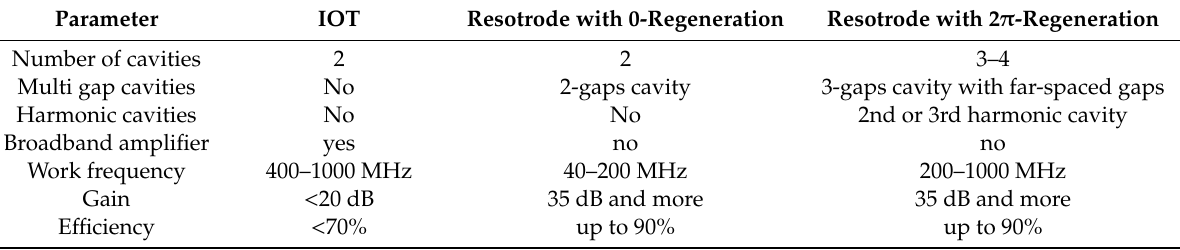
Table 2. Comparison of IOTs with